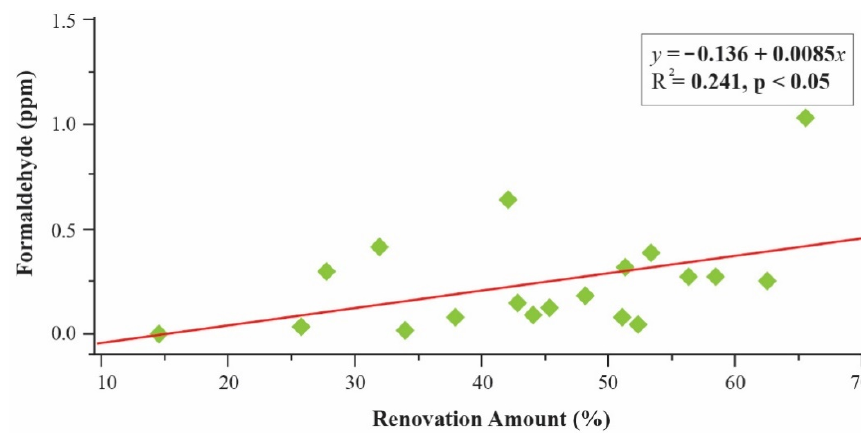
Figure 9. TVOC concentration and daily ventilation.